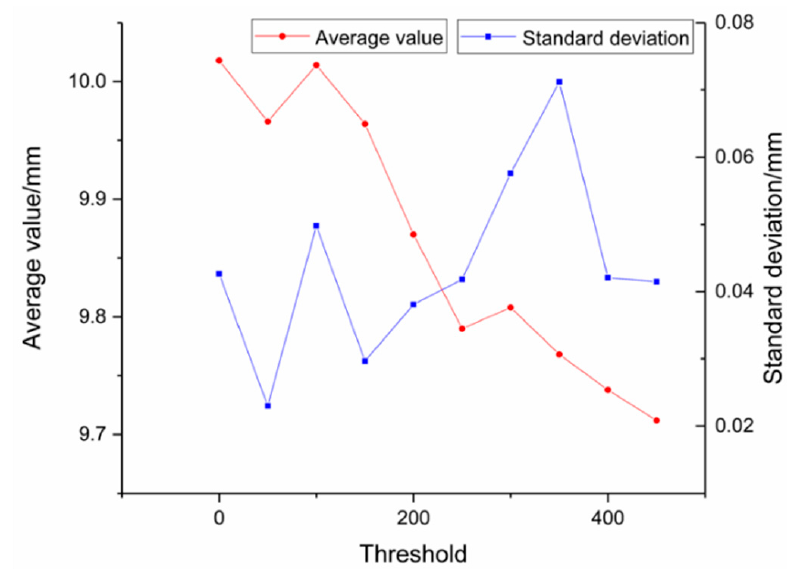
Figure 14. The average value and standard deviation in pixel threshold experiment.